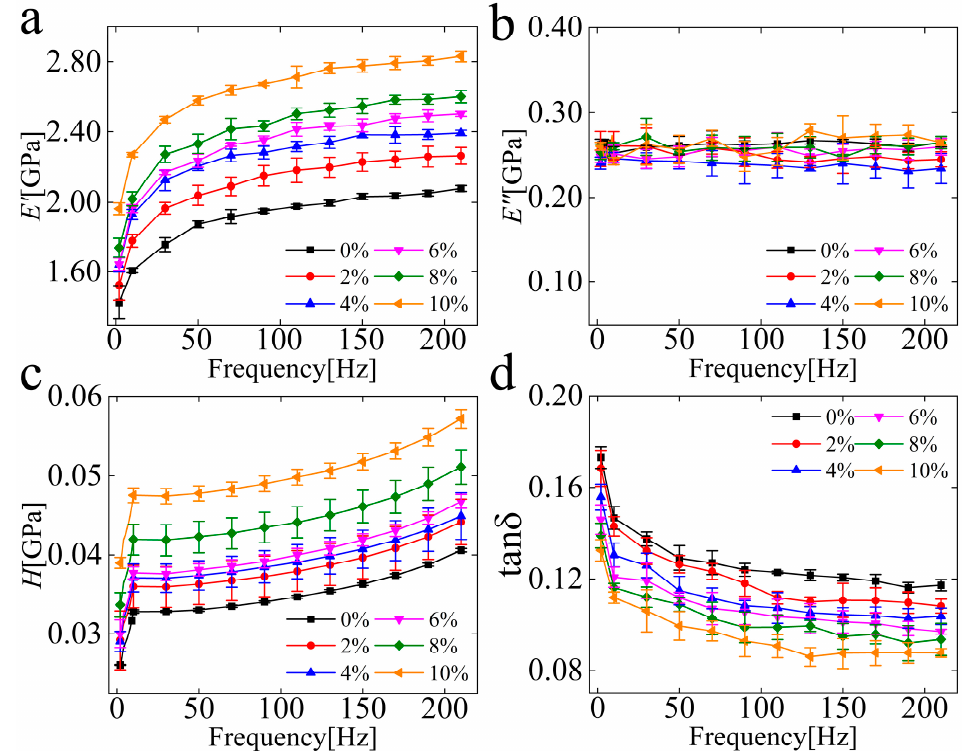
Figure 3. Results of dynamic nanoindentation tests. ( a ) Storage modulus; ( b ) Loss modulus; ( c ) Sur- face hardness; and ( d ) Loss factor of the composites with different nanoparticle contents as functions of the testing frequency. of the testing